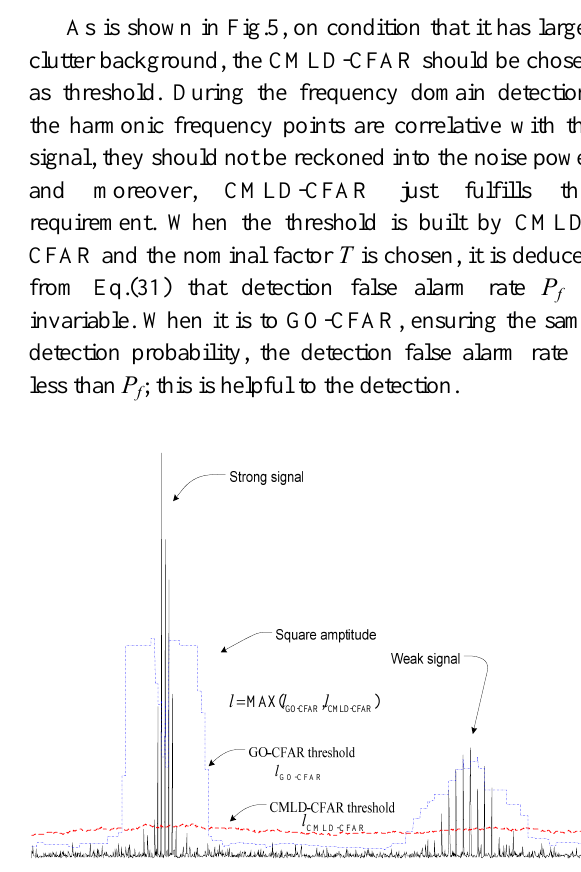
Fig.5 Simulation of the threshold